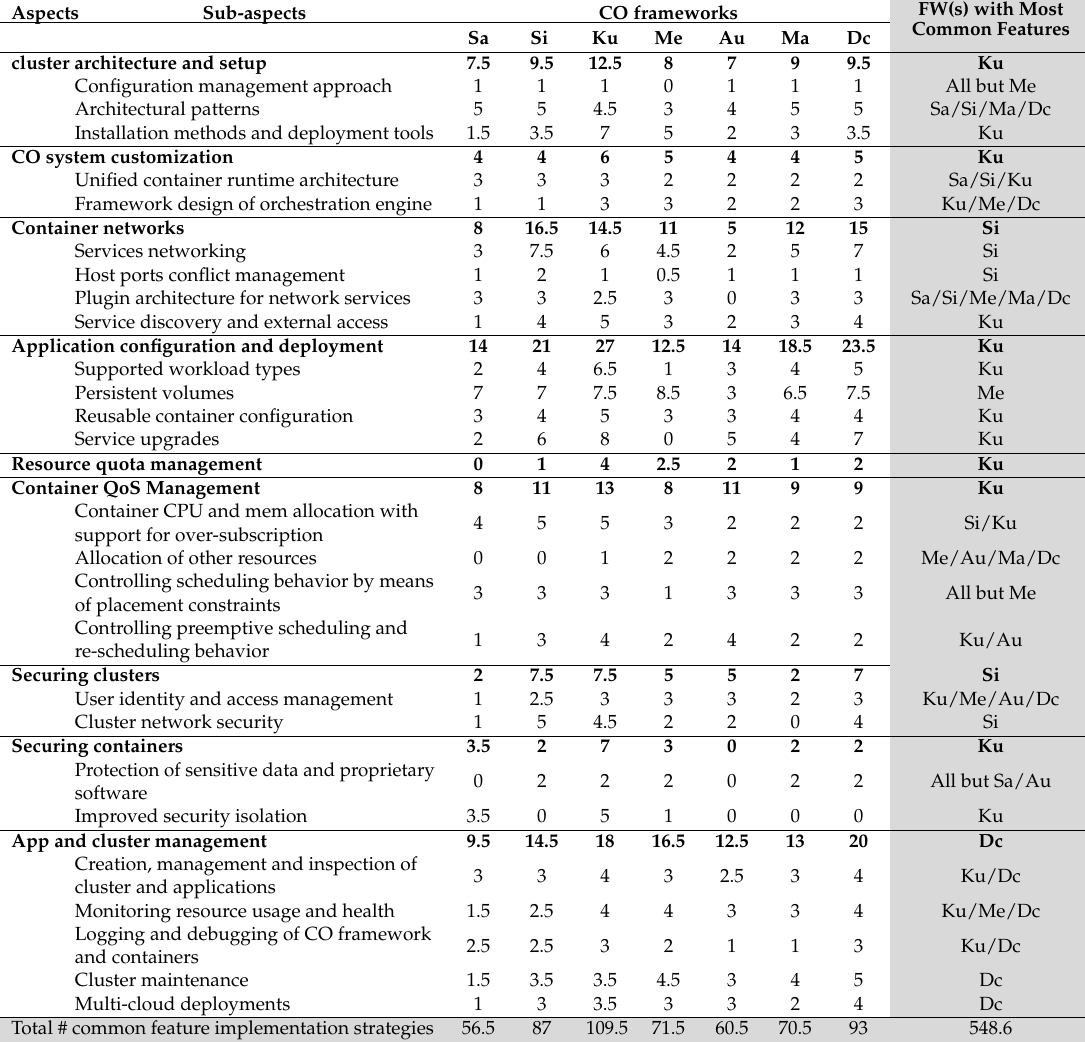
Table 5. For each functional (sub)-aspect, the number of common feature implementation strategies by each CO framework are shown and the framework(s) with the highest number is/are also shown.